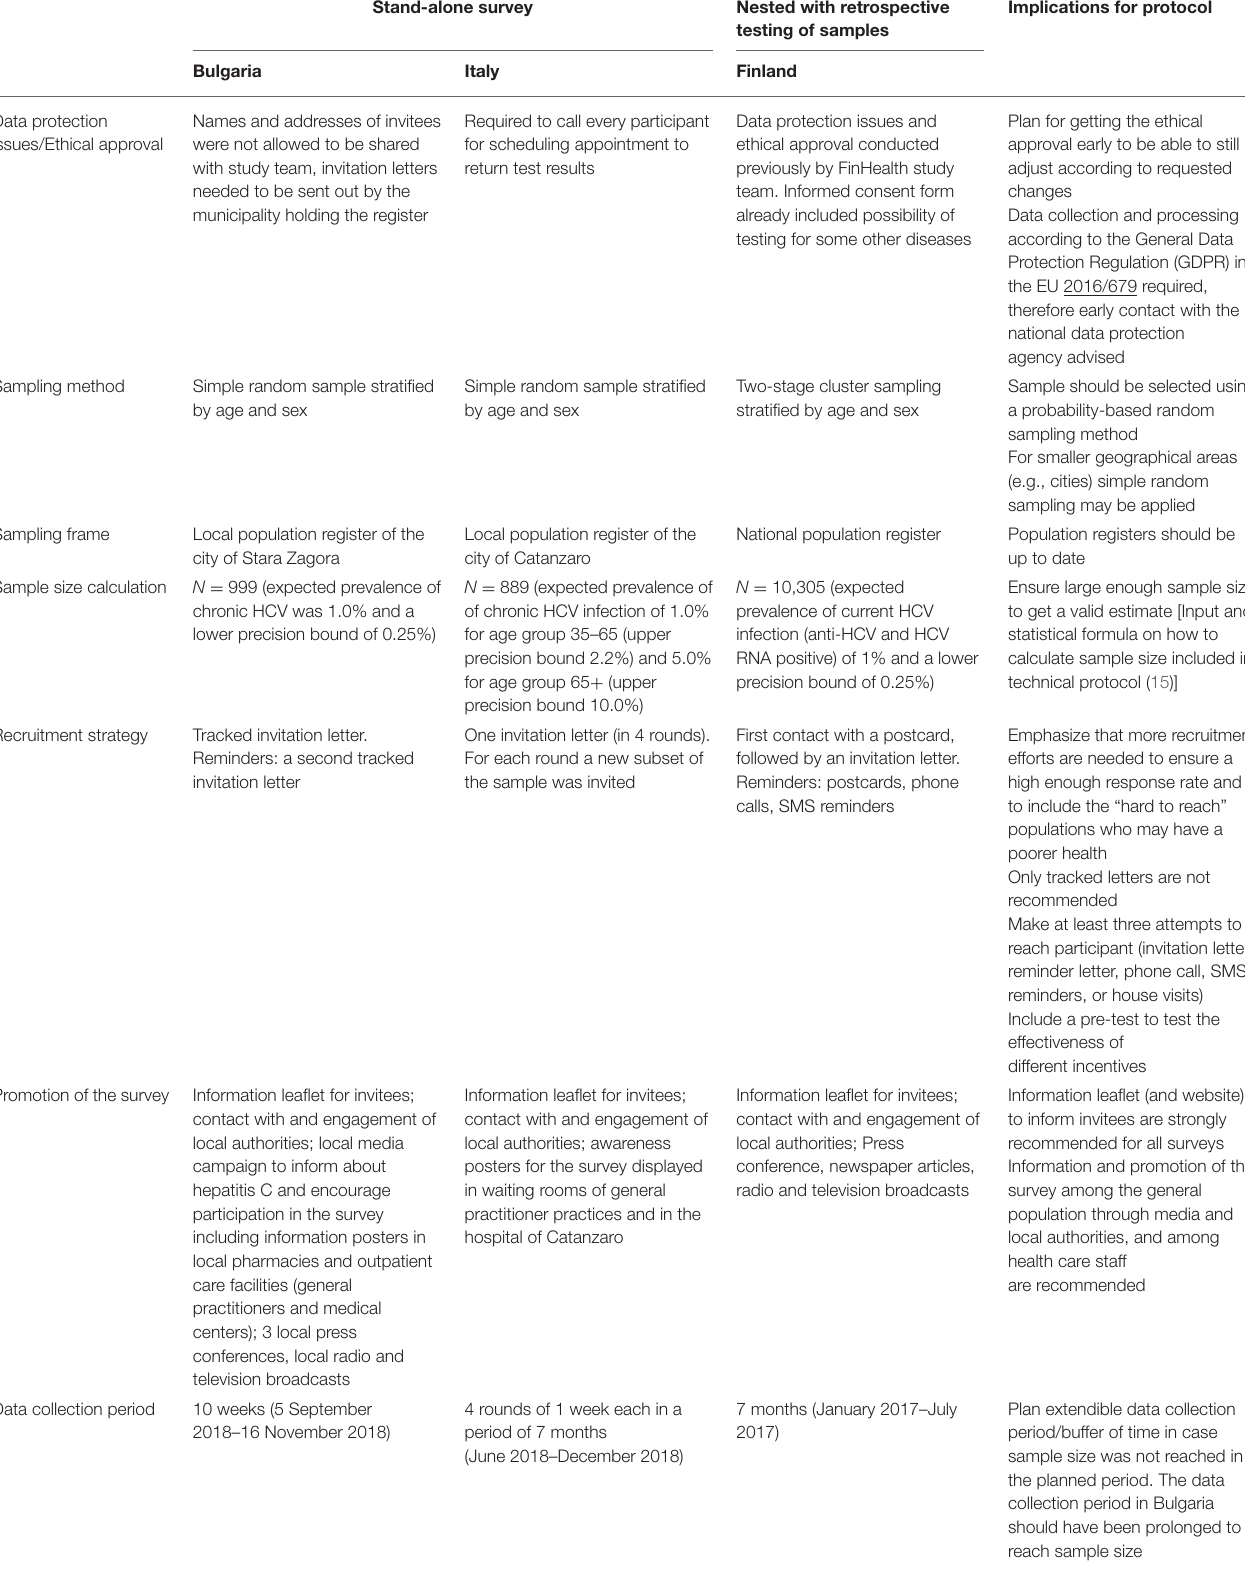
TABLE 1 | Summary of methodological details, results of the pilots, lessons learnt, and implications for the technical protocol